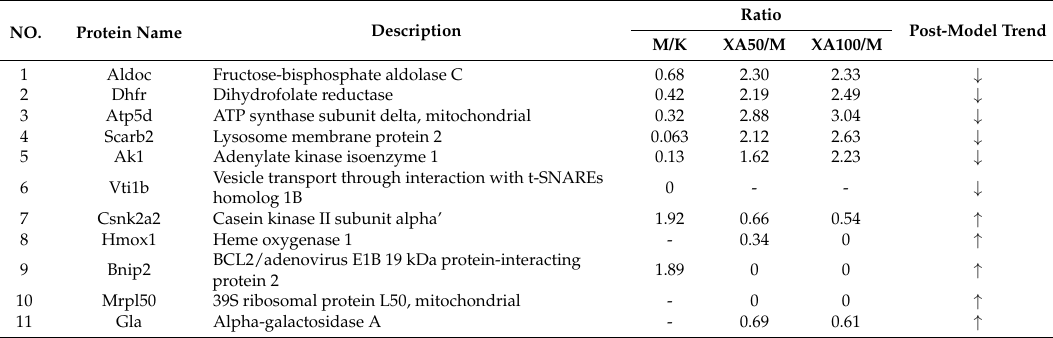
Figure 5. Heat map analysis of 34 differentially expressed proteins. K: Control group; M: Model group; XA50: 50 µ M XA; XA100: 100 µ M XA. Table 8. Significant differentially-expressed proteins related to the neuroprotective effect of N -benzylhexadecanamide (XA).